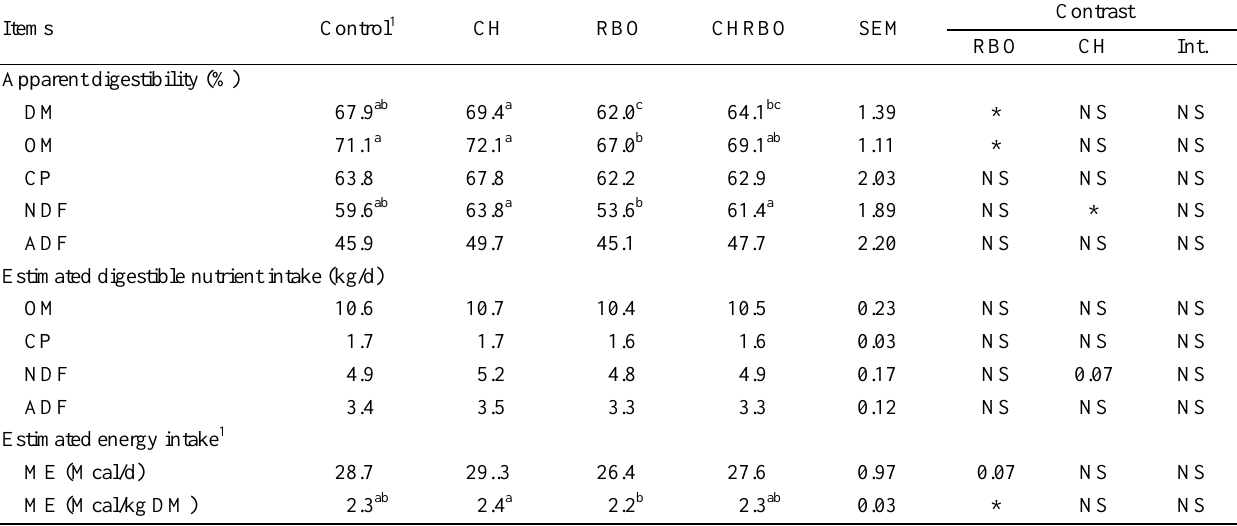
Table 3. Effect of cassava hay and rice bran oil on nutrient digestibility and nutrient intake in lactating dairy cows Items